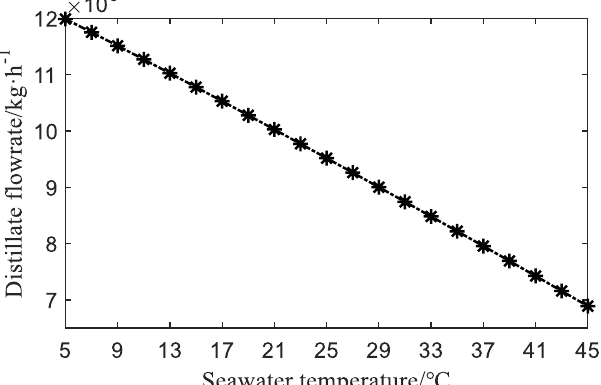
Figure 3. Effect of seawater temperature ( sea T ) on brine temperature (top brine temperature (TBT) and bottom brine temperature (BBT)).